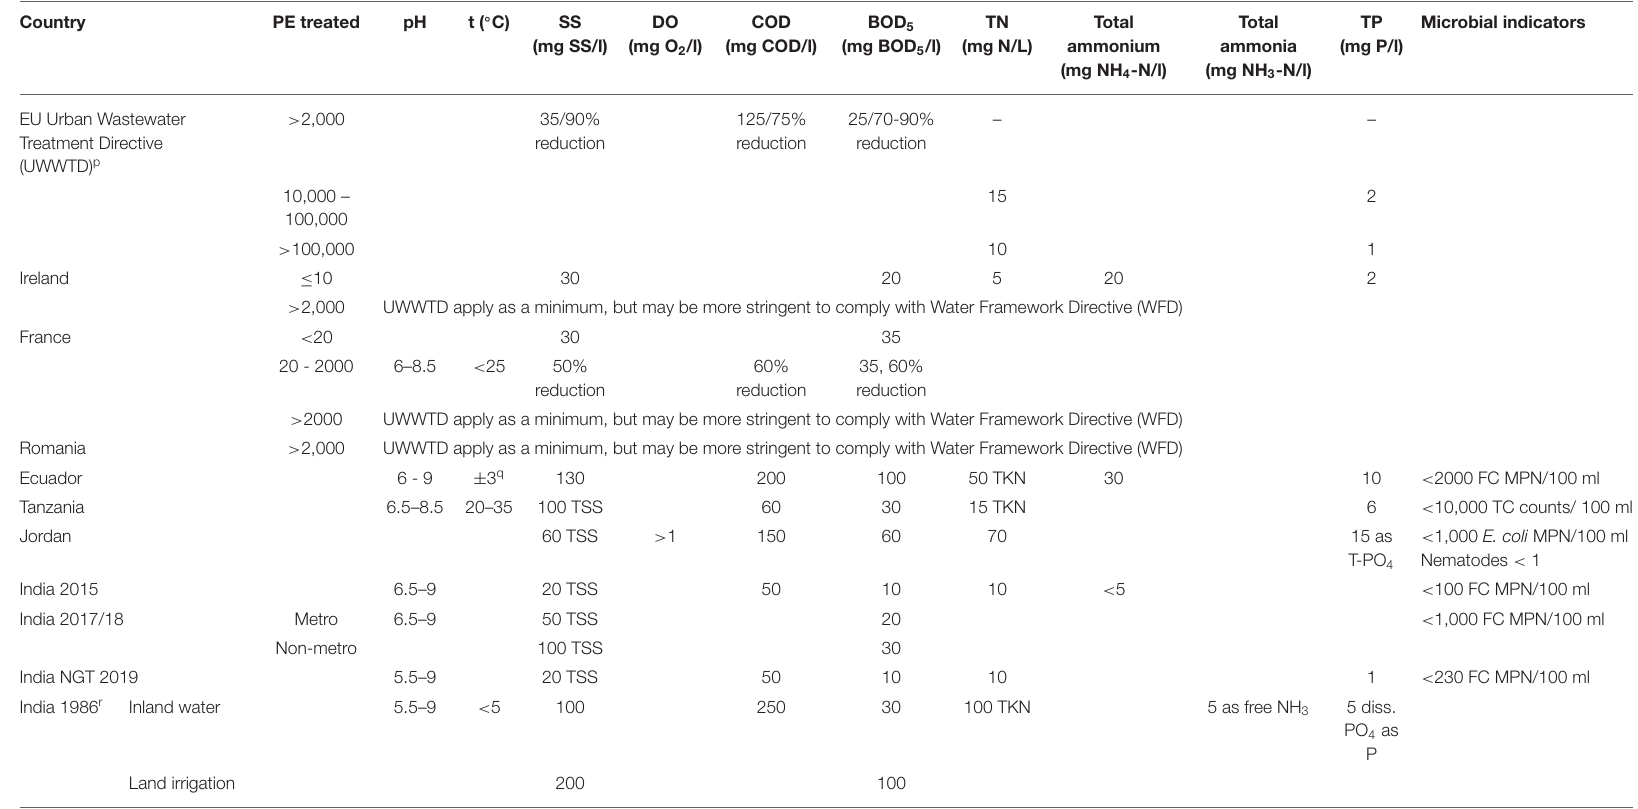
Note to the table: Coliforms represented include E. coli, Fecal Coliforms (FC) and Total Coliforms (TC). o Detail for ranges of permitted consents omitted from this version for clarity. p TP and TN only considered in designated “sensitive” areas. q Of the receiving water